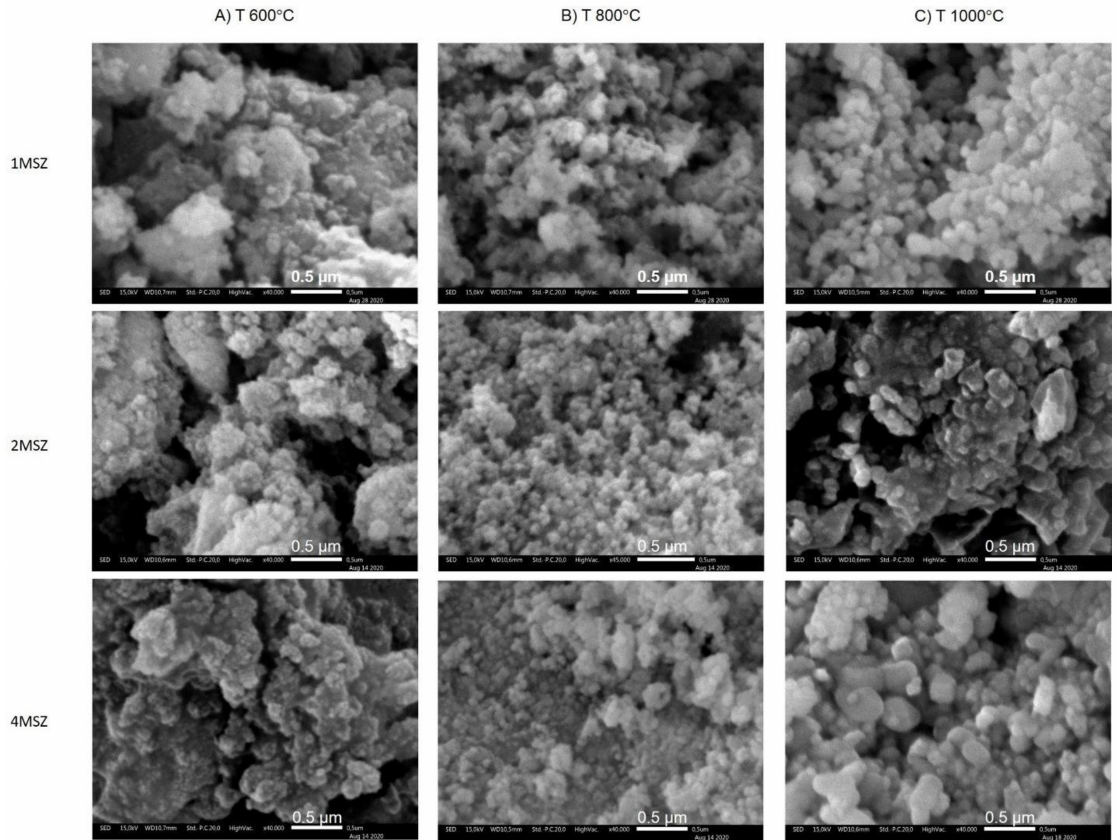
Figure 4. SEM micrographs of MSZ samples after calcination at 600 ◦ C ( A ), 800 ◦ C ( B ), and 1000 ◦ C ( C